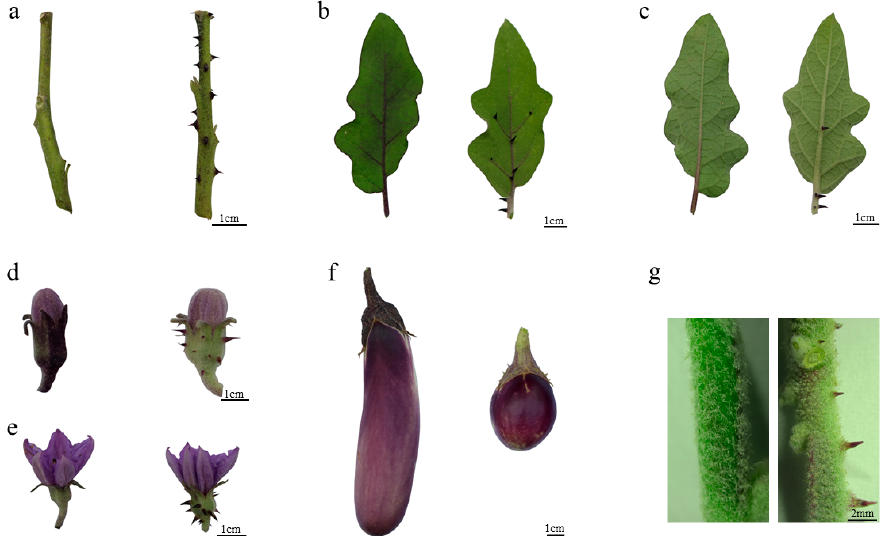
Figure 1. Morphological comparison of prickleless and prickly eggplants. ( a ) Stems from prickleless and prickly eggplants; ( b ) Adaxial side of leaves from prickleless and prickly eggplants; ( c ) Abaxial side of leaves from prickleless and prickly eggplants; ( d ) Budding flowers from prickleless and prickly eggplants; ( e ) Blooming flowers from prickleless and prickly eggplants; ( f ) Fruits from prickleless and prickly eggplants; ( g ) Stereo microscope images of stems from prickleless and prickly eggplants. Black bars are scales of either 1 cm or 2 mm.